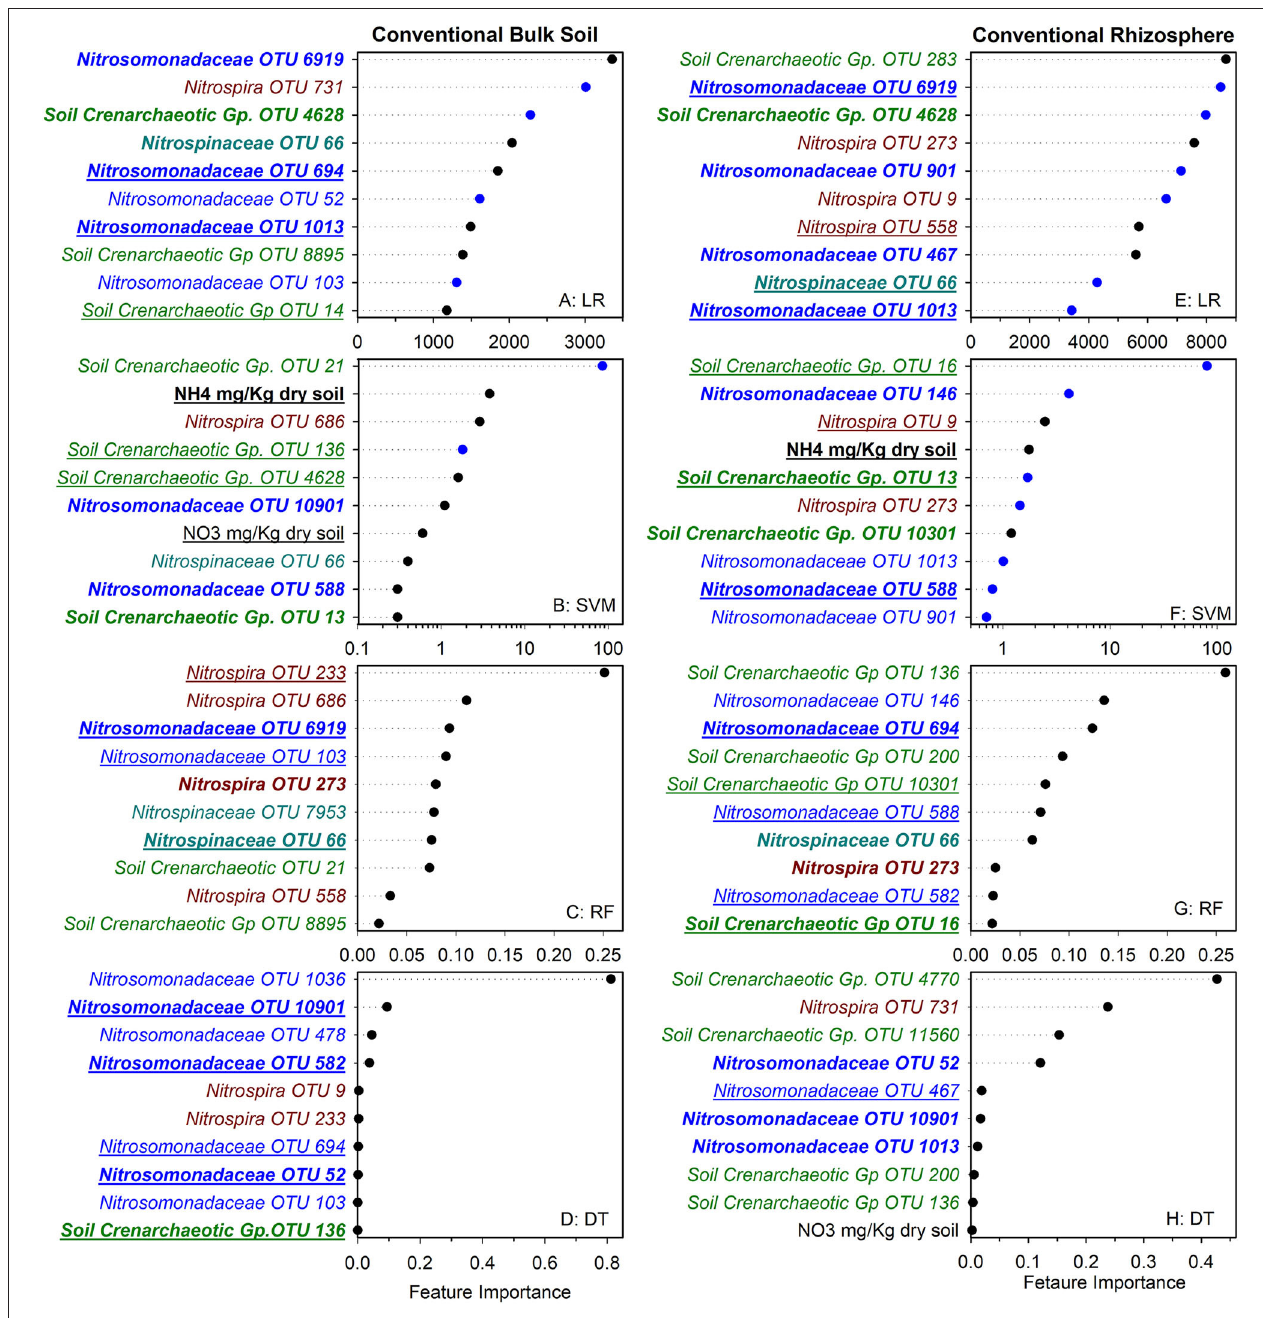
FIGURE 1 | Ranks of absolute feature weights of linear (A,B,E,F) and nonlinear (C,D,G,H ) models for conventional bulk soil and rhizosphere. The 10 highest ranked features in absolute feature weights are displayed from highest to lowest. In regression (A,E) and SVM (B,F) , the features and importance of OTUs that were positively associated with nitrification are represented by black dots, and those negatively associated with nitrification are shown in blue. The values for linear regression are the absolute feature importance, while for SVM, the log 10 relative absolute feature importance. Within each model, bold OTUs indicate the same OTUs in bulk soil and rhizosphere within a cropping system, and underlined features indicate the same OTUs in bulk soil or rhizosphere between cropping systems. Random Forest (C,G) . Decision Tree (D,H) .